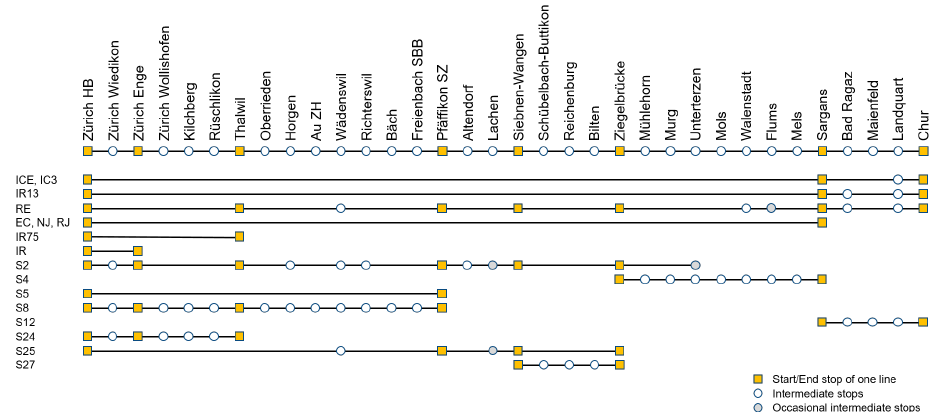
Figure 3. Line plan of services within the corridor